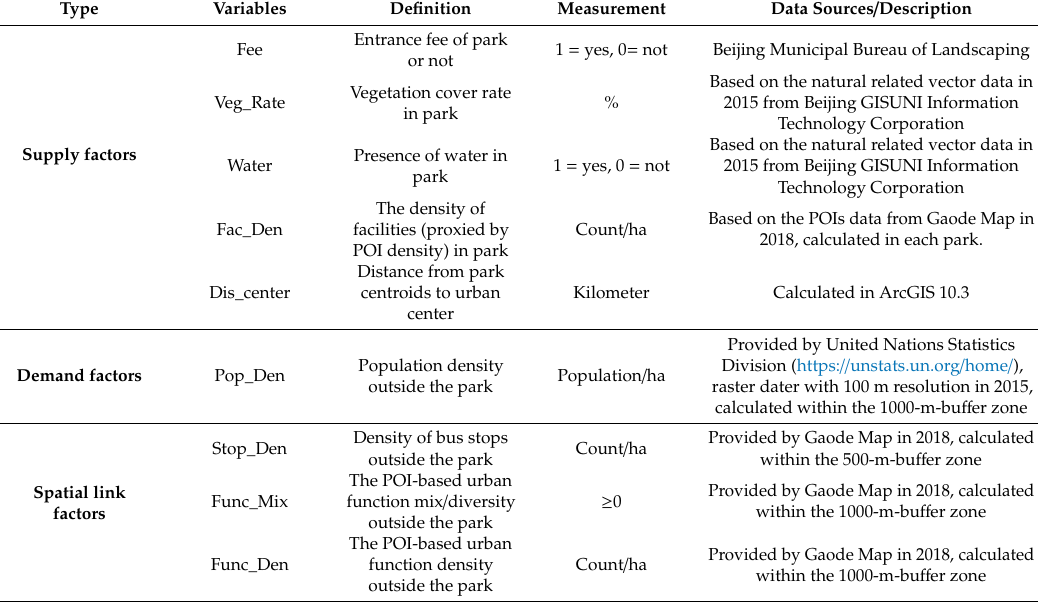
Table 2. Descriptions and data sources of selected potential factors a ff ecting park